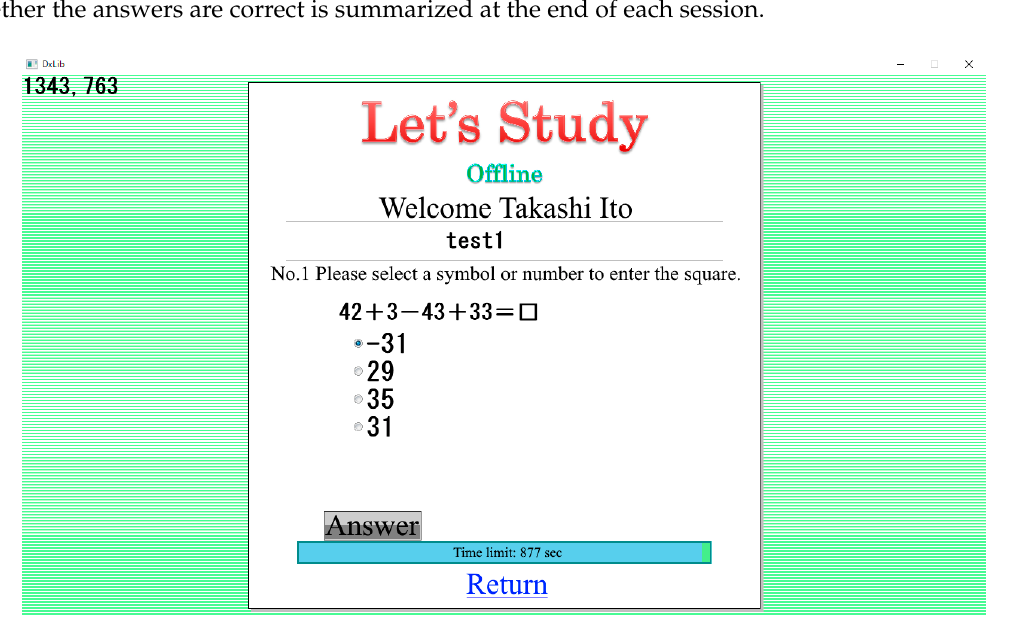
Figure 3. A page for mathematical calculation.